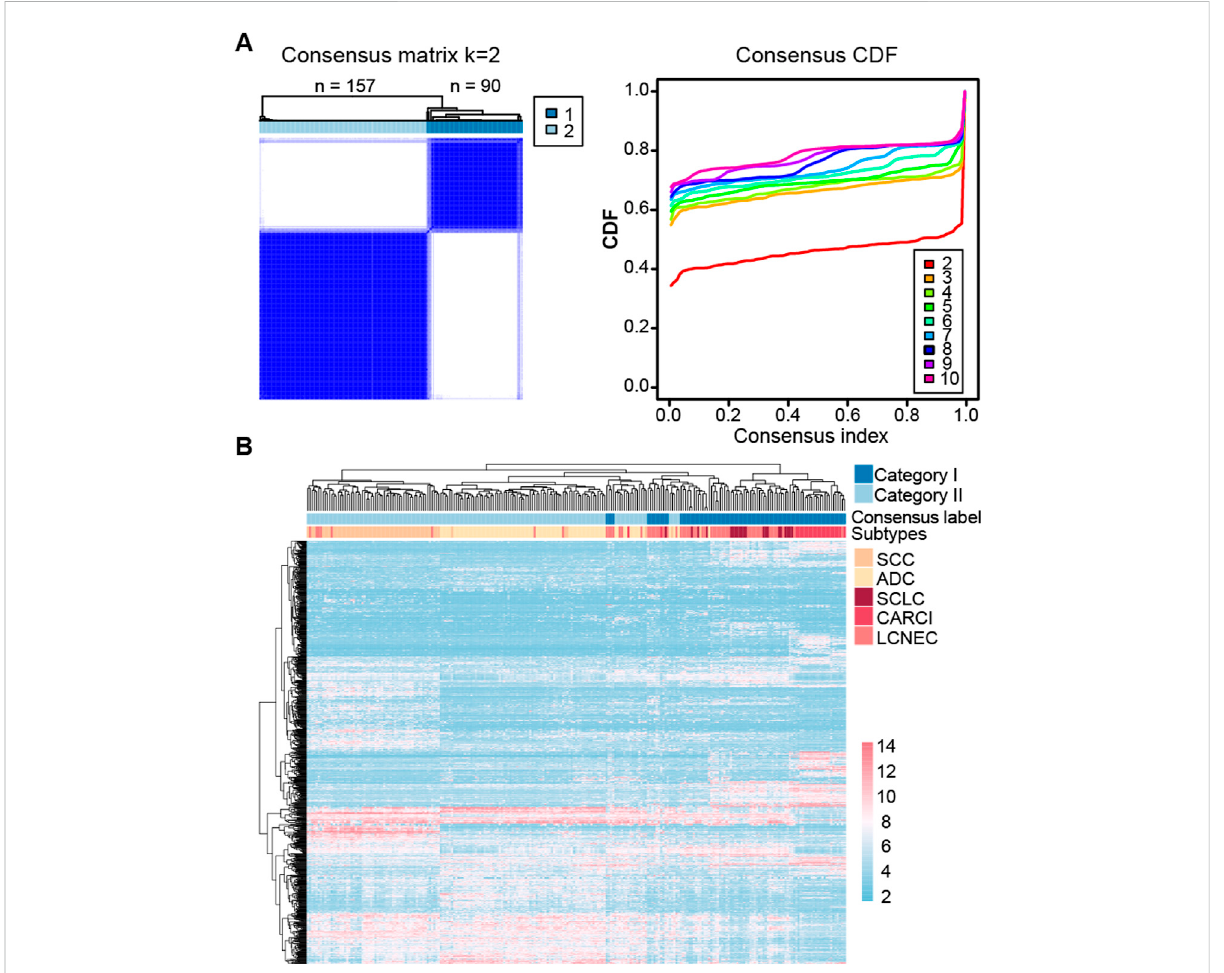
FIGURE 2 Clustering heatmap of lung cancer subtypes in the GSE30219 dataset. (A) consensus clustering of all the lung cancer samples based on the top 1,000 most variable genes in the dataset. The left panel represents the matrix heatmap when k = 2, and the right panel represents the consistent cumulative distribution function graph. (B) hierarchical clustering of all the samples based on the top 1,000 most variable